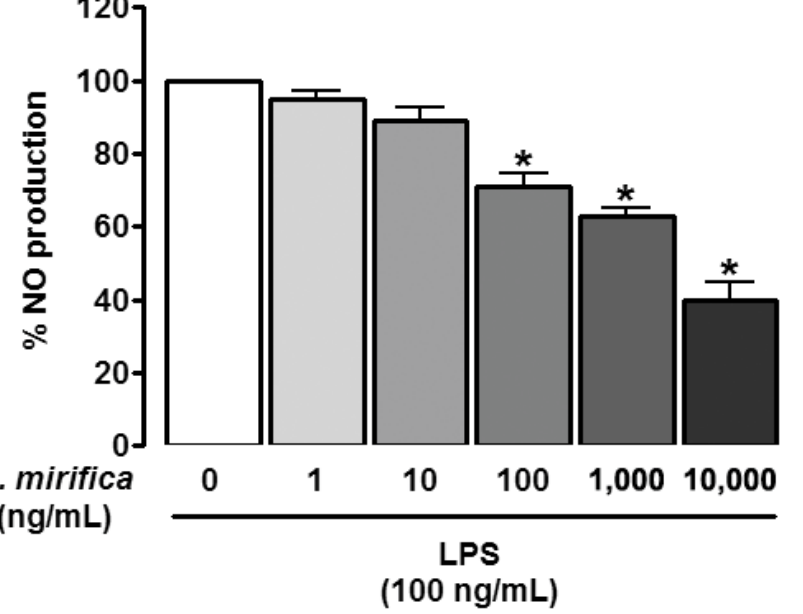
Figure 2. Effects of P. mirifica extract on LPS-induced NO production. HAPI cells (10 5 cells/well) were treated with different concentrations of P. mirifica ethyl acetate extract for 1 h prior to administration of LPS (100 ng/mL) for 24 h. The amount of NO produced in the culture supernatants was determined with a Griess assay. Values are the mean percentage ± SD of six samples from three different experiments compared with the corresponding LPS-treated control (100%). * p < 0.05 compared with the LPS-treated control.